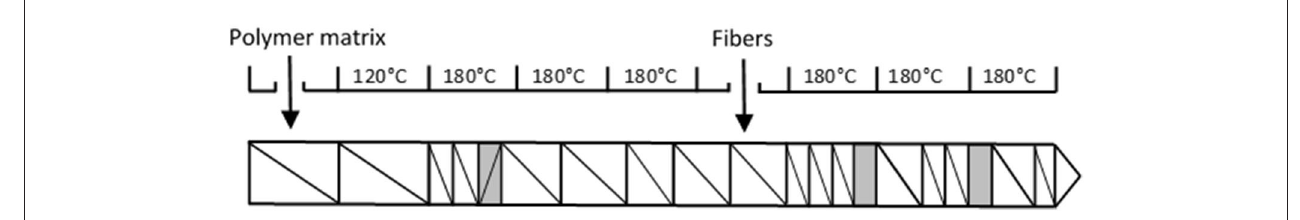
FIGURE 8 | Modified screw profile. The restrictive elements are in